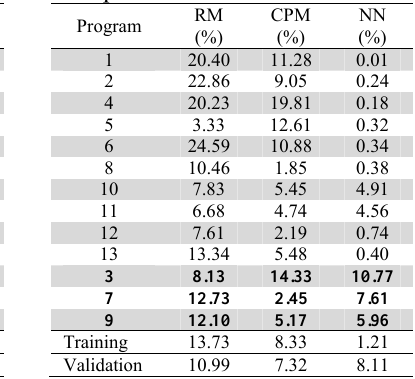
Comparison of Errors for Trial 1 Comparison of Errors for Trial 2 Comparison of Errors for Trial 3